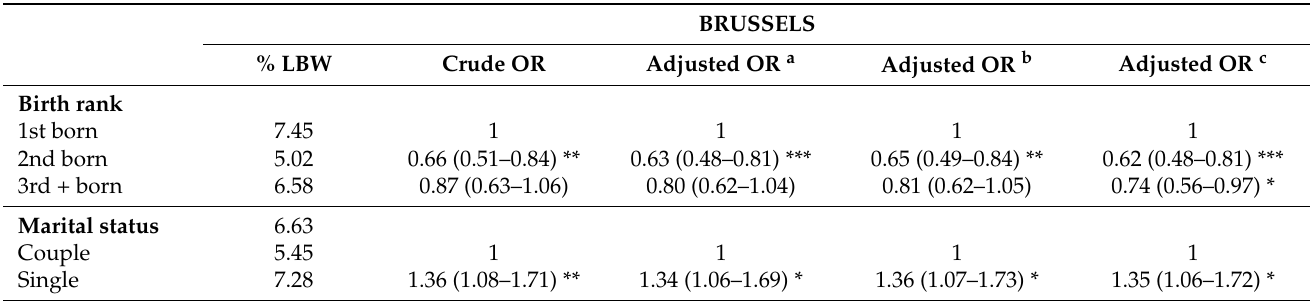
Table 5. Risk of LBW according to household composition among welfare